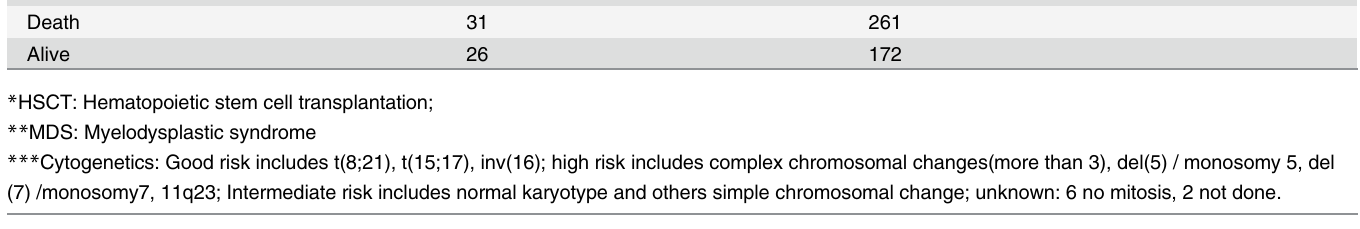
hepatitis B carriers and four patients with positive anti-HBsAb and anti-HBcAb. One